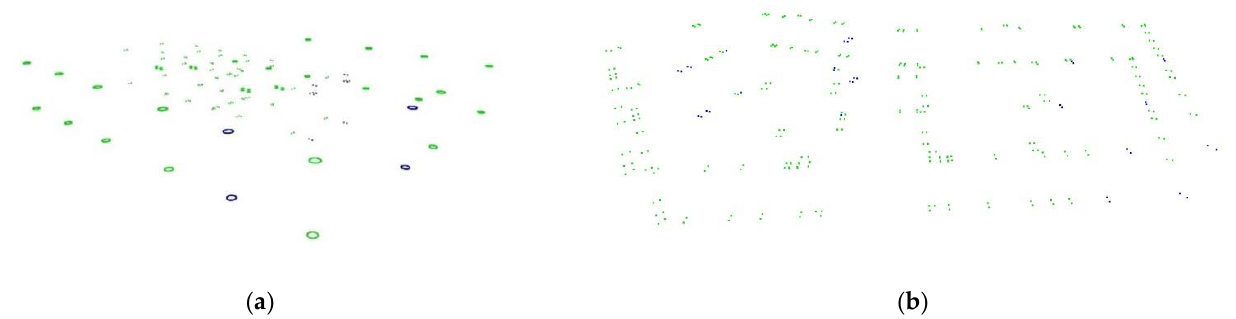
Figure 13. Object detection: ( a ) SQVERAS 3rd, and ( b ) PILIAMIESTIS A1.